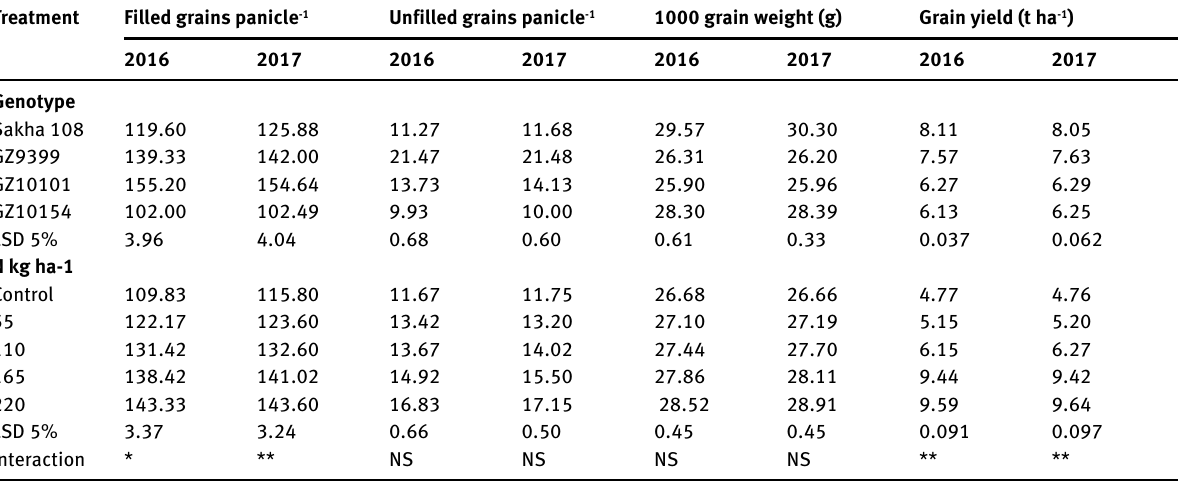
Table 3: Filled grains panicle -1 , unfilled grains panicle -1 , 1000 grain weight and grain yield t ha -1 of rice genotype as affected by nitrogen levels in 2016 and 2017